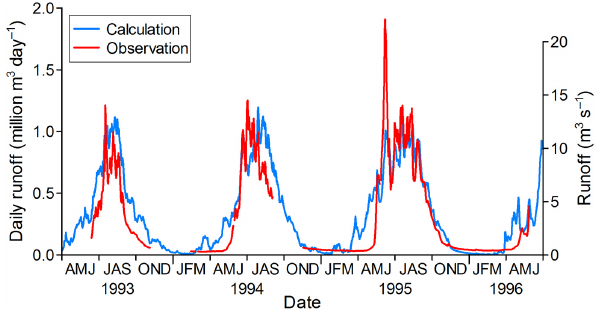
Figure 8. Observed and calculated runoff at the outlet of the Tsho Rolpa Glacial Lake–Trambau Glacier basin for the period 1993– 1996 (location shown as yellow cross in Fig. 1a).